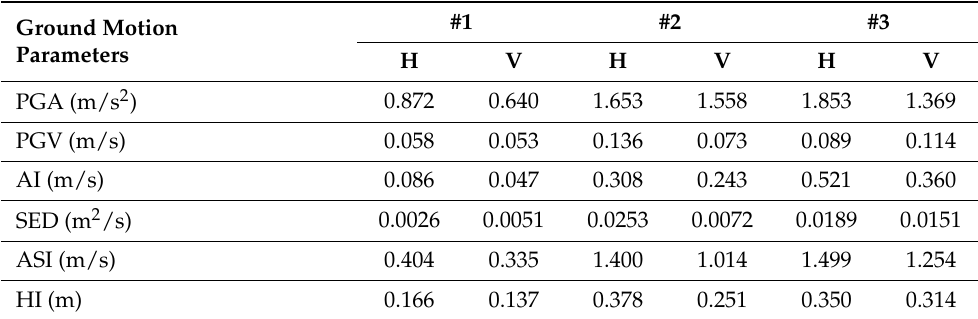
Table 5. Ground motion parameters of the H and V components of #1, #2, and #3 ground motion records.